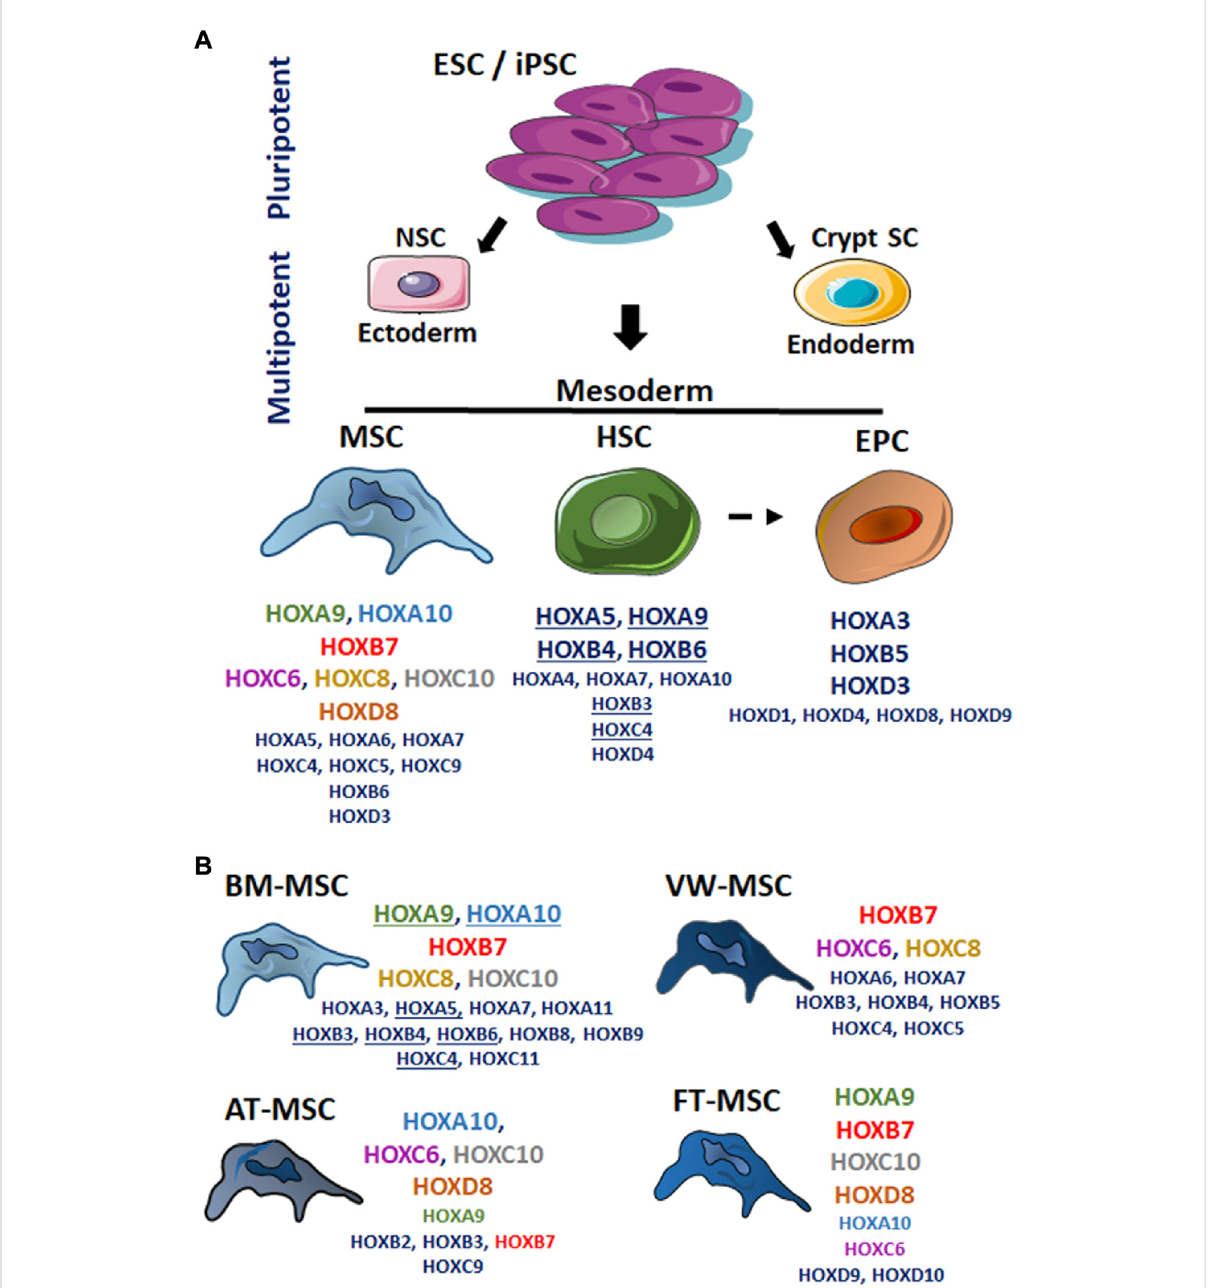
FIGURE 3 The HOX code of mesodermal stem cells. Stem cells derived from different tissues present patterns of HOX gene expression ( “ the HOX code ” ) that mirrors their developmental origin. According to the fact that HOX genes are not expressed before gastrulation, HOX genes were not found to be transcribed in non-differentiated, pluripotent stem cells (SC) due to active epigenetic repression of HOX genes. In cells, particularly stem cells lying at equivalent anteroposterior positions but in distinct embryonic germ layers, HOX proteins have distinct regulatory activities. (A) The reported HOX expression pattern for the mesodermal-derived adult stem cell types were listened: mesenchymal stem cell (MSC), hematopoietic stem cell (HSC) and endothelial progenitor cell (EPC). (For details: see main text.) (B) HOX expression pattern for bone marrow (BM)-, vascular wall (VW-),adiposetissue(AT)-,andfetaltissue(FT;summarizingumbilicalcord,placentaandamniotic fl uidMSCs)-MSCswereseparatelyshown.Capital letters name more frequently identi fi ed HOX genes potentially representing the cell type-speci fi c HOX code, whereas smaller letters designate individual additionally identi fi ed HOX genes above it. Same colors highlight same HOX genes that are common in different MSC types; underlined HOX genes emphasize similar HOX genes between BM-MSCs and HSCs. ESC, embryonic stem cell; iPSC, induced pluripotent stem cell; NSC neural stem